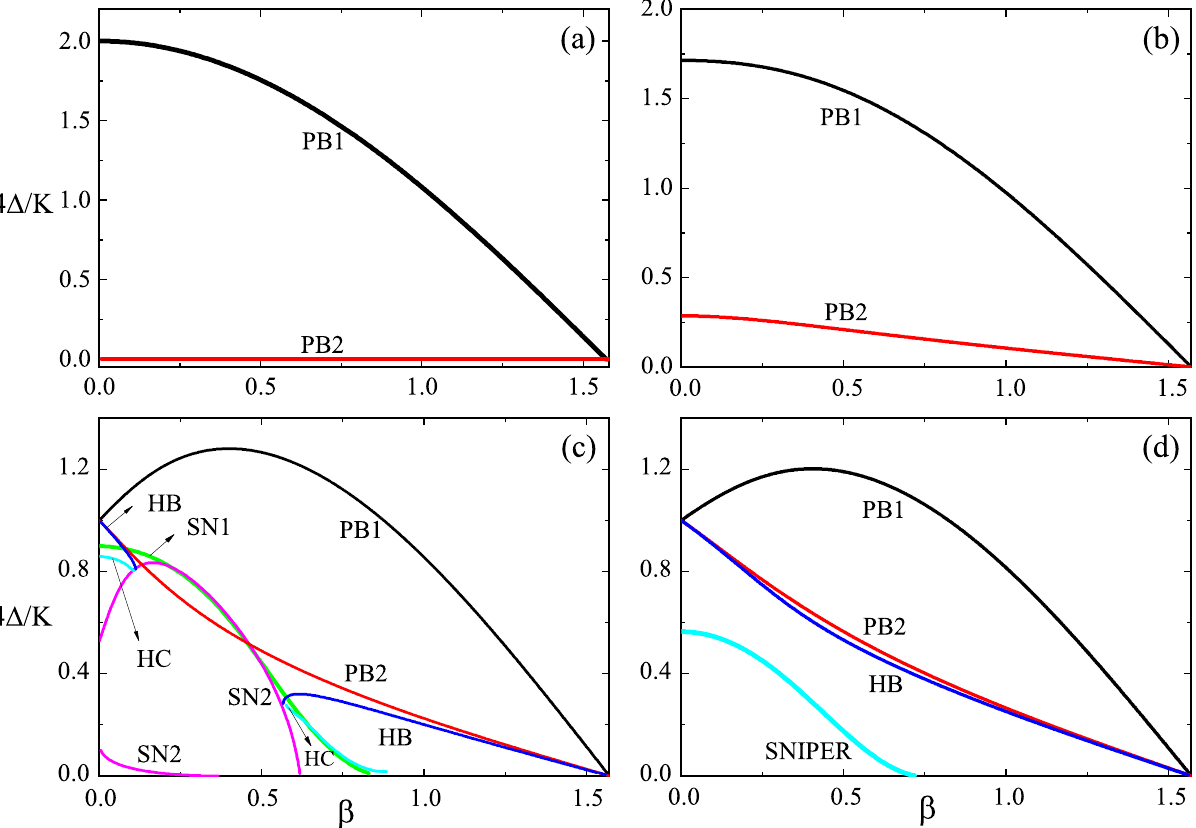
Fig 4. (Color online) Phase diagrams on the plane of Δ 0 = 4 Δ / K and β at ω 0 (d). K =